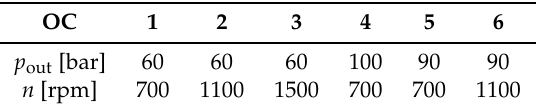
Table 9. Operating conditions measured ( p in = 2.5 bar, T in = 20